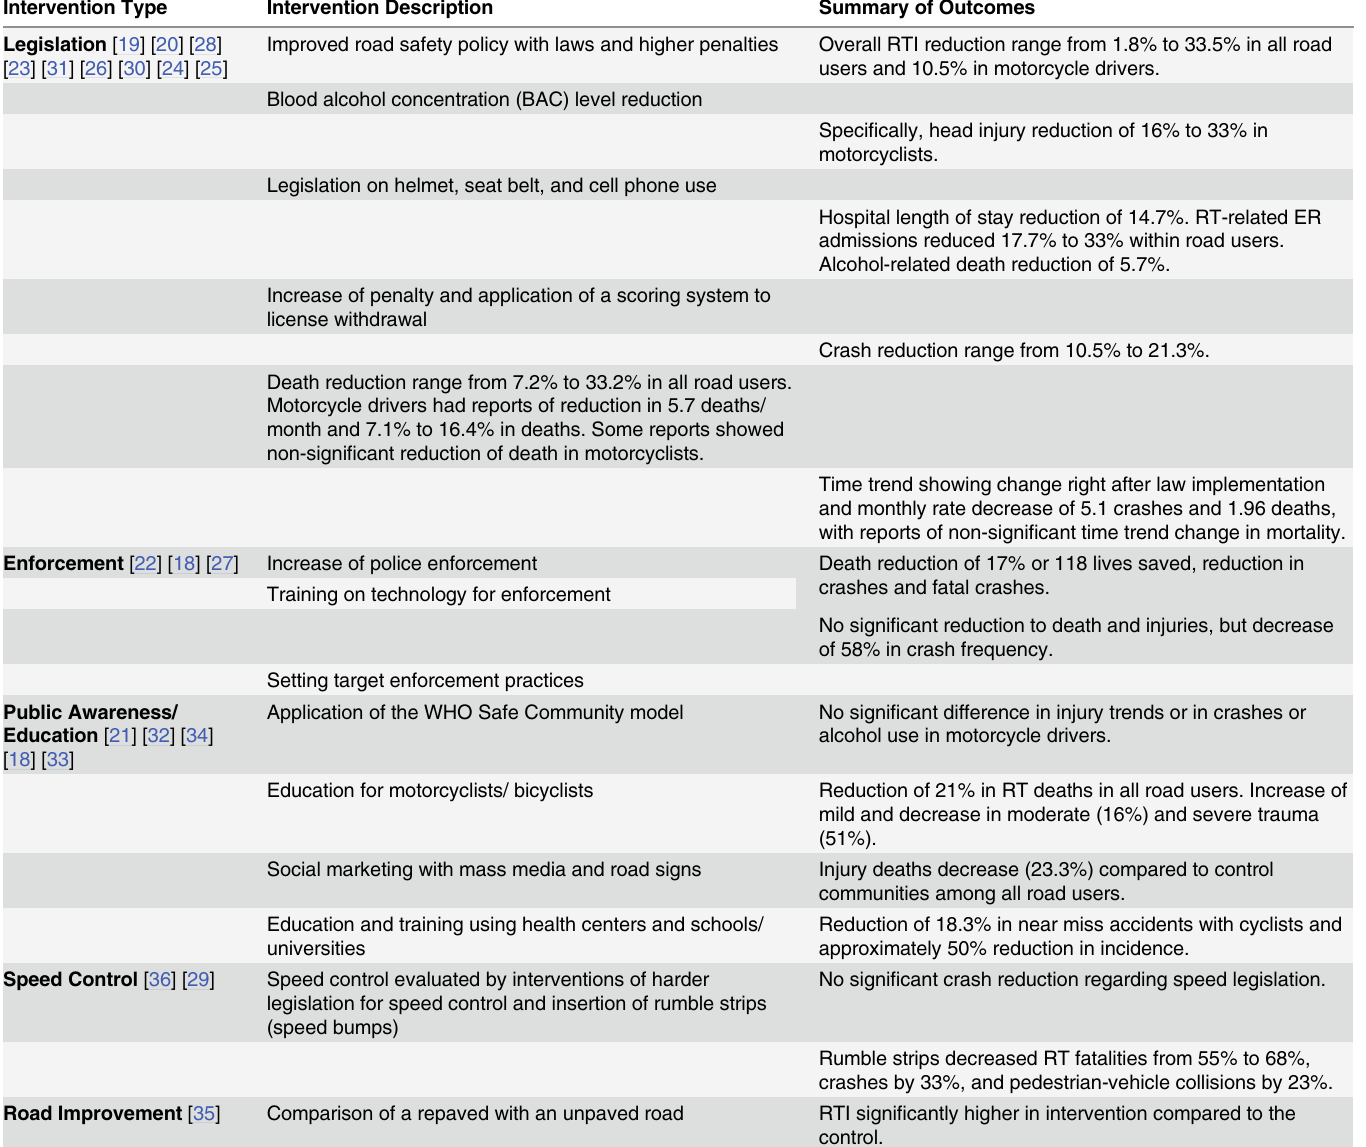
Table 2. Intervention description and summary of